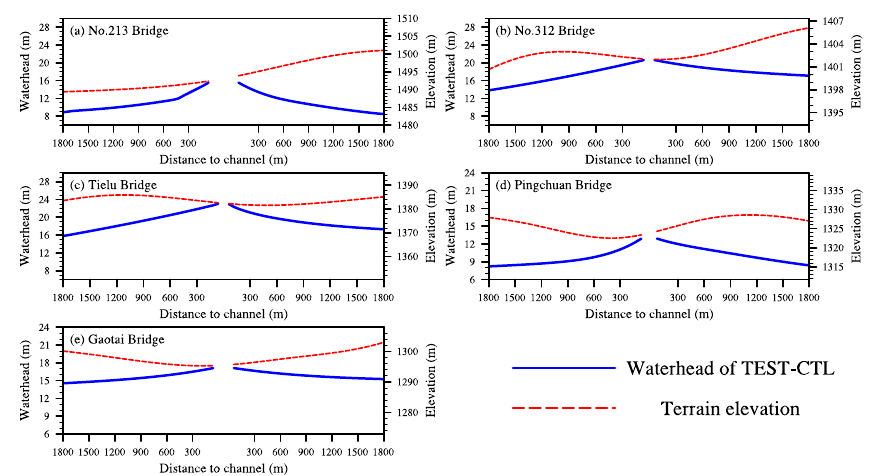
Figure 13. Differences between annual water heads predicted by TEST and CTL simulations and terrain elevations along the five sections at (a) 213 Bridge, (b) 312 Bridge, (c) Tielu Bridge, (d) Pingchuan Bridge, and (e) Gaotai Bridge. The discontinuous parts of the curves represent the river areas.